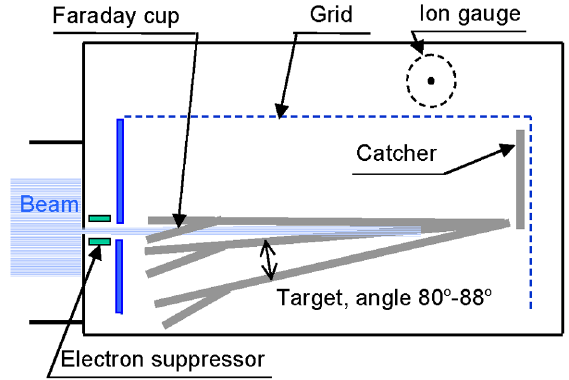
FIG. 1. (Color) The gas-electron source diagnostic (GESD) measures electron emission and gas desorption caused by an ion beam, incident from the left on a target at grazing angles. The target is shown at three possible angles, the upper position exposes a Faraday cup under the target to the ion